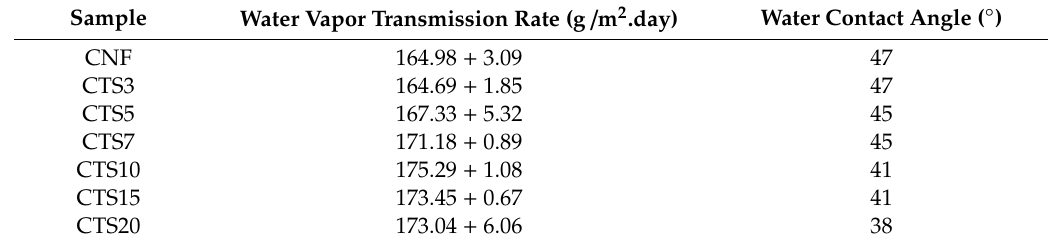
Table 2. Water vapor transmission rate and water contact angle of CNF and ChNF–CNF